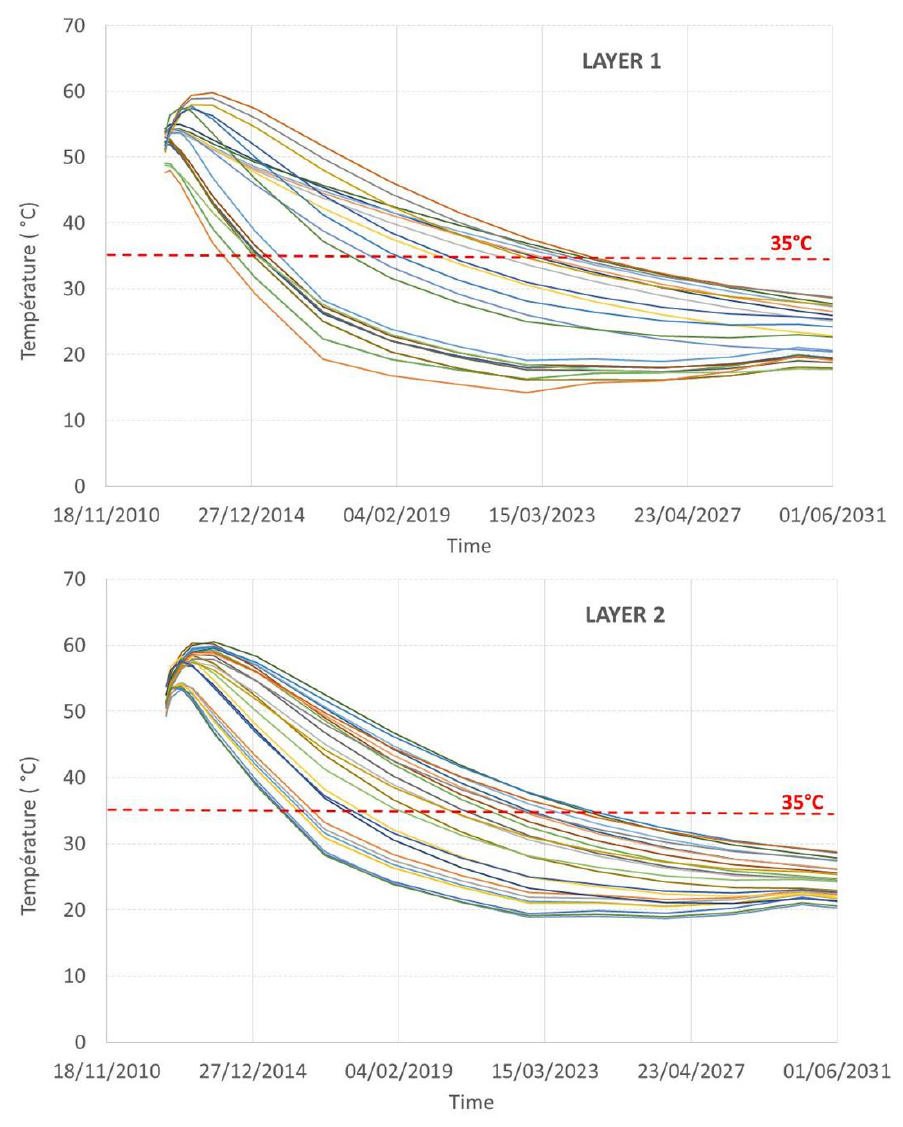
Figure 11. Simulation of CELL4 temperature evolution until 2030 for Layer 1 and Layer 2.